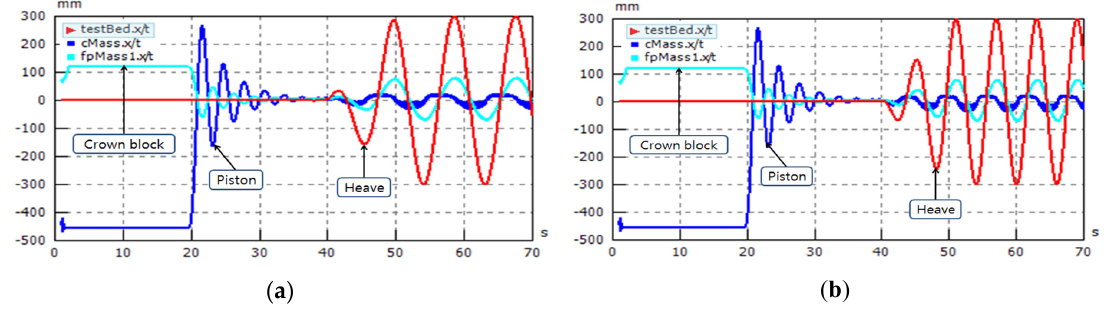
Figure 6. Results of oil pressure analysis, ( a ) ±0.3 m (1/9) Hz; ( b ) ±0.3 m (1/6) Hz.